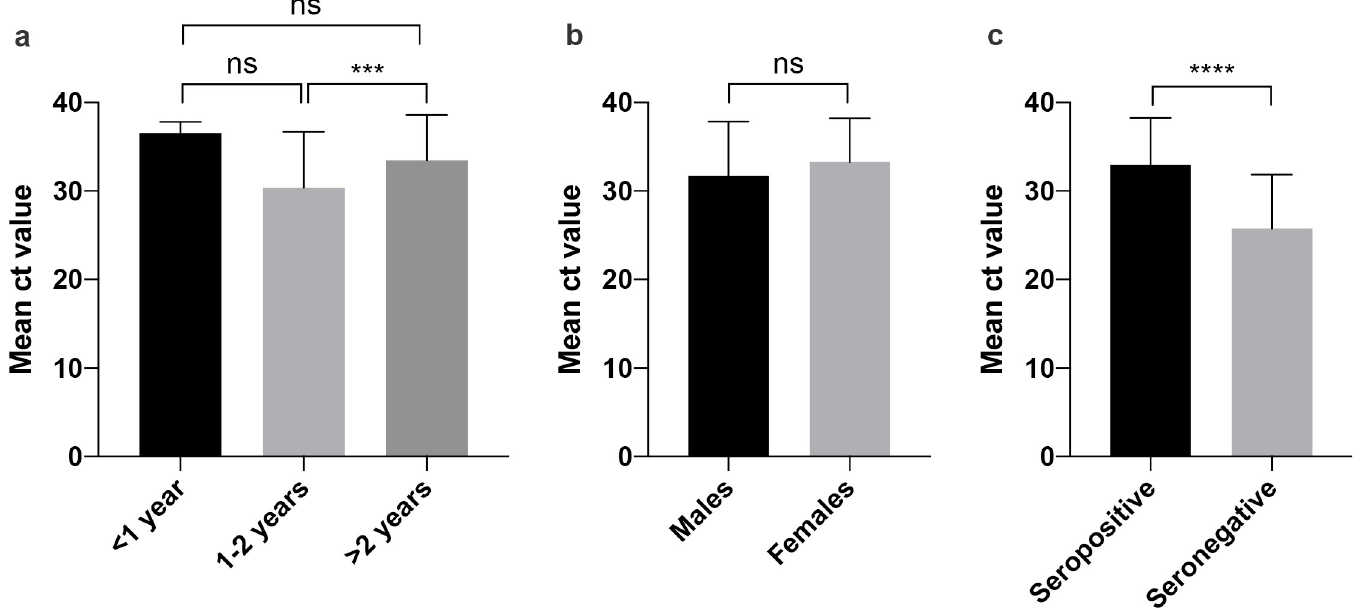
Fig 4. Comparison of MERS-CoV RNA load based on age, sex and presence of nAbs. One-way ANOVA with Bonferroni post-test was used for (a) and student’s t test was used in (b and c). ���� p < 0.0001, ��� p < 0.001 and NS denotes not statistically significant.